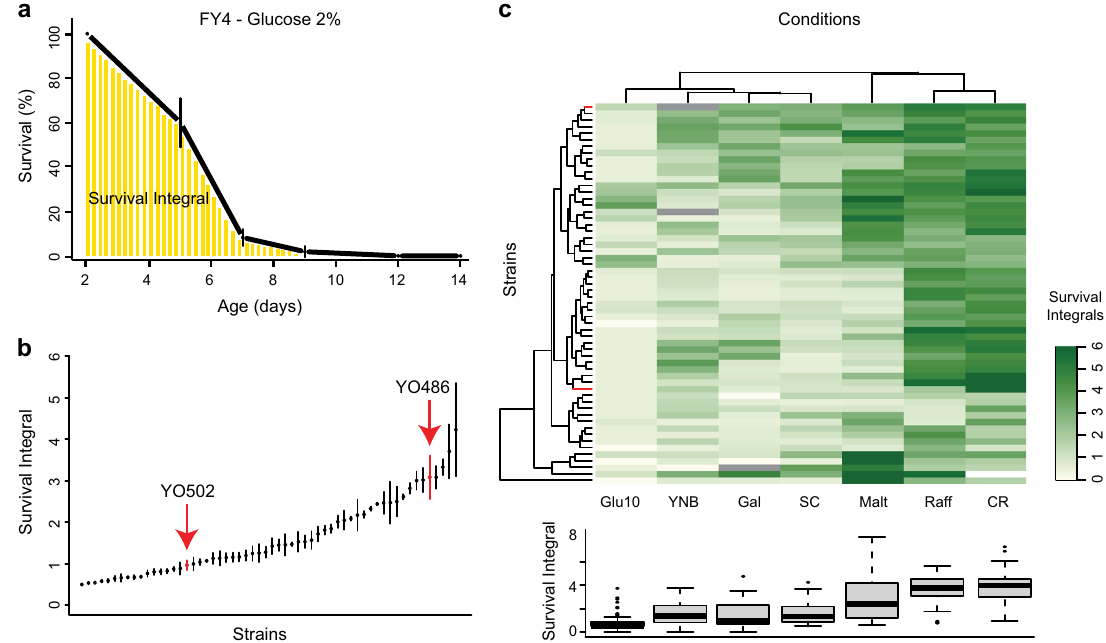
Fig. 1 Chronological life span variation in a natural yeast strain collection. a Representative chronological life span (CLS) assay, based on determination of the Survival Integral (SI), for the FY4 strain in our standard SC medium. b CLS determination for our natural strain collection in SC condition. Arrows indicate the parental strains of the “ sake × tecc cross ” . c Heatmap and boxplot representation of CLS variation within the natural strain collection in seven different conditions. The color gradient represents SI variation with dark and light green corresponding to long and short life span, respectively. Gray rectangles in the heatmap indicate no growth of the corresponding strains in the respective conditions. Strains depicted in red correspond to the parental strains of the “ sake × tecc cross